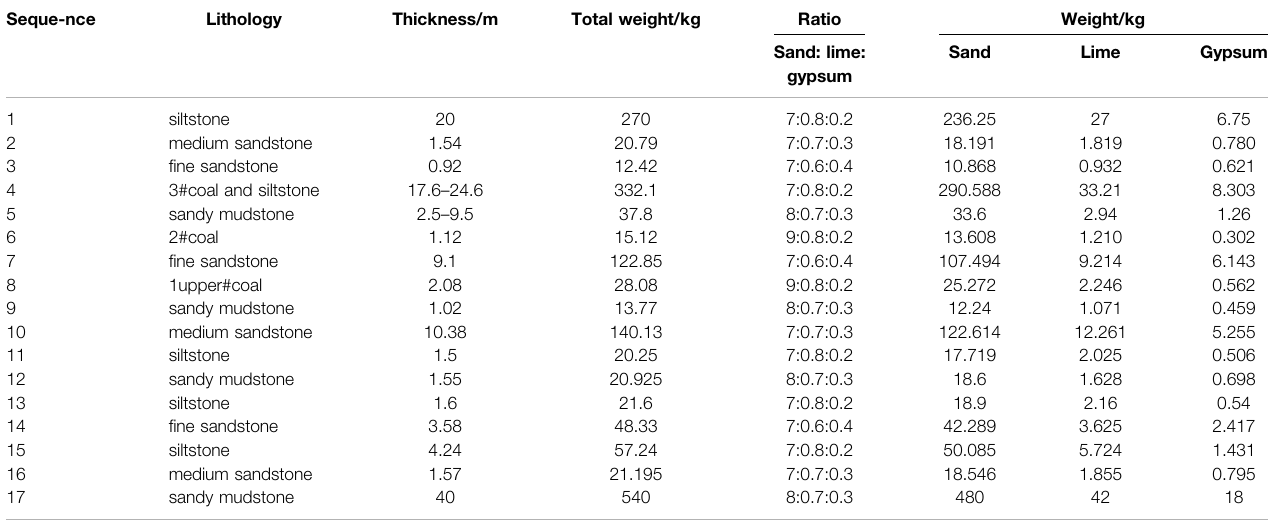
TABLE 1 | Proportion and dosage of similar materials in the test model.